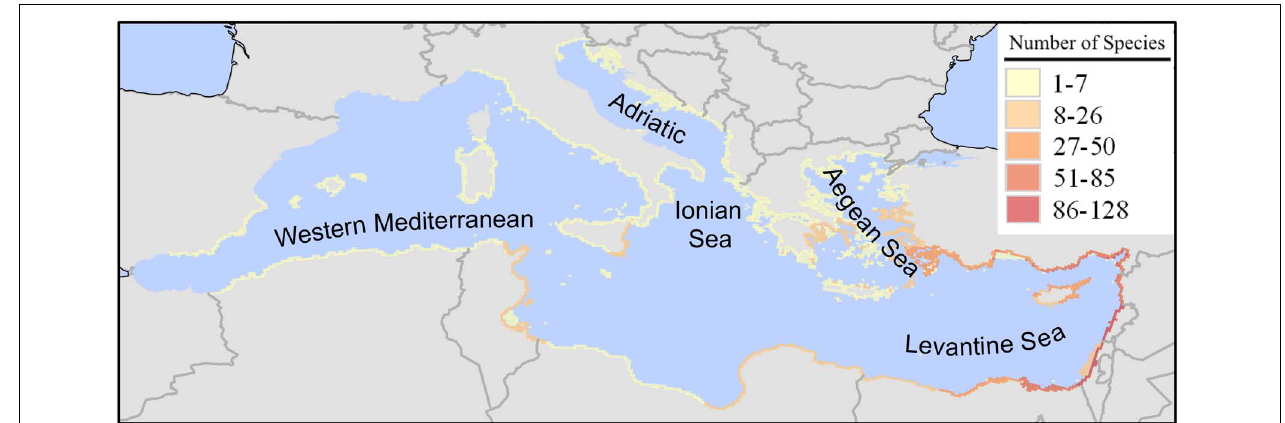
FIGURE 2 | Richness (number of species in a 10 × 10km grid) of marine alien species introduced in the Mediterranean Sea through the Suez Canal (Lessepsian immigrants). Map was produced by EASIN’s mapping widget.